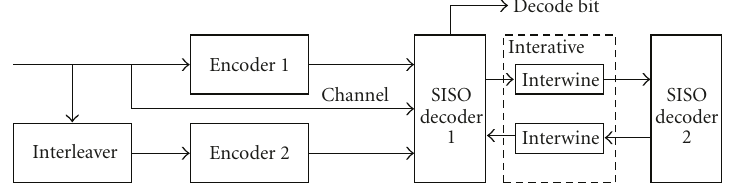
Figure 1: Framework of Turbo code.